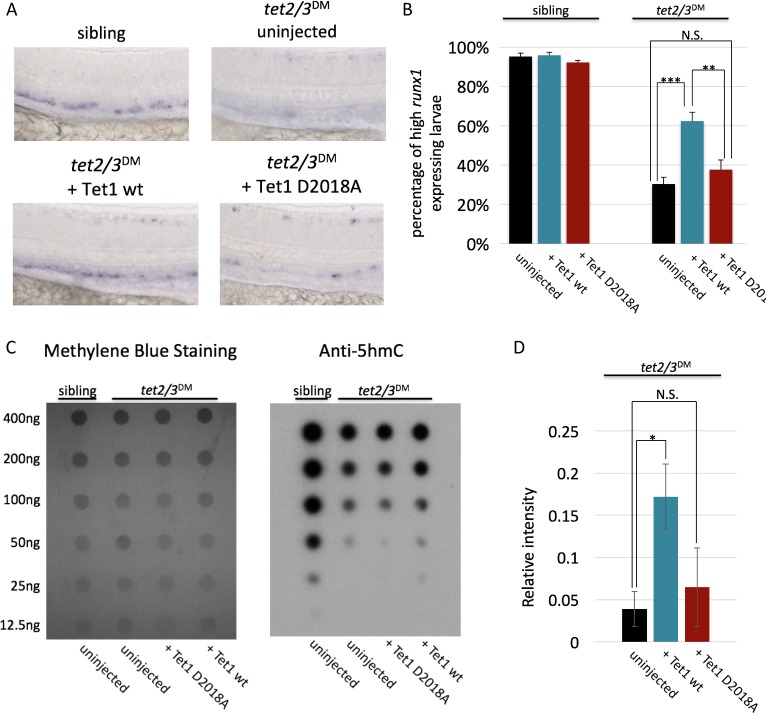
The TET1-OGT interaction promotes TET1 function in the zebrafish embryo.(A) Representative images of runx1 labeling in the dorsal aorta of wild type or tet2/3DM zebrafish embryos, uninjected or injected with mRNA encoding mouse Tet1 wild type or D2018A. (B) Percentage of embryos with high runx1 expression along the dorsal aorta. (C) 5hmC dot blot of genomic DNA from wild type or tet2/3DM zebrafish embryos injected with Tet1 wild type or D2018A mRNA. Methylene blue was used as a loading control. (D) Quantification of 5hmC levels from three dot blots, normalized to methylene blue staining. Error bars denote s.d. *p<0.05, **p<0.01, ***p<0.001, N.S. – not significant.10.7554/eLife.34870.009Figure 5—source data 1.For Figure 5B Quantification of runx1 levels in zebrafish embryos used to generate graph in Figure 5B.